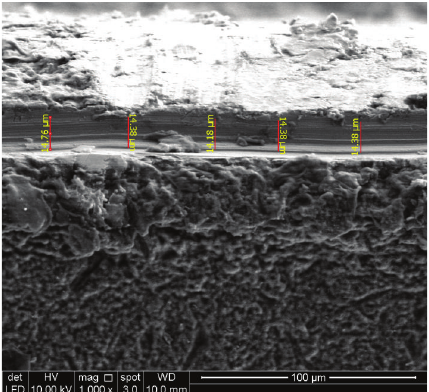
Figure 7: Showing 14.4 ± 0.2 𝜇 m surface layer thickness of the sample on the fifth day of Tas-SBF